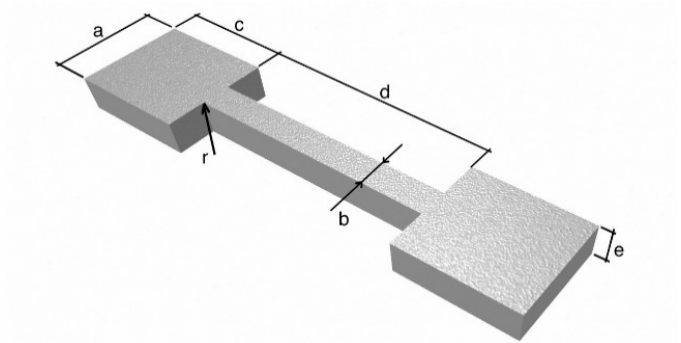
Figure 1. Geometry of the creep samples (a = 10 mm, b = 3 mm, c = 15 mm, b = e = 3 mm, and r = 0.5 mm).